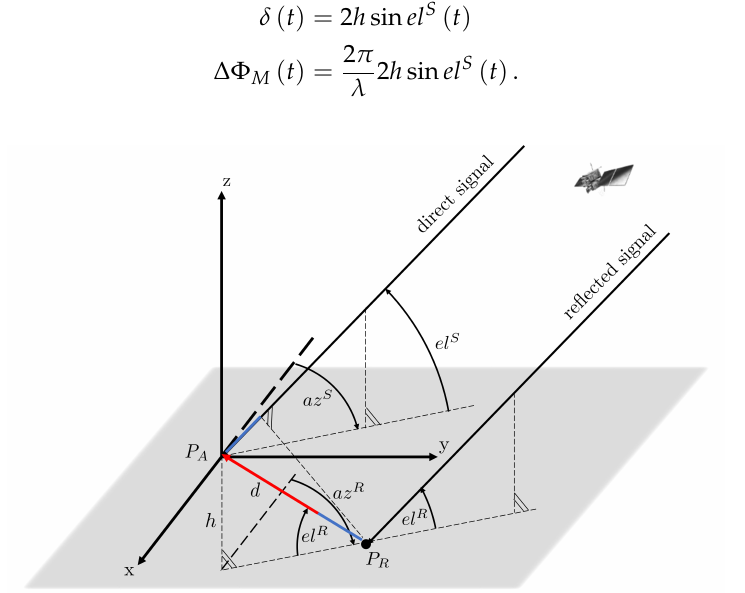
Figure 3. Geometrical satellite-reflector-antenna configuration for the special case of a single horizontal